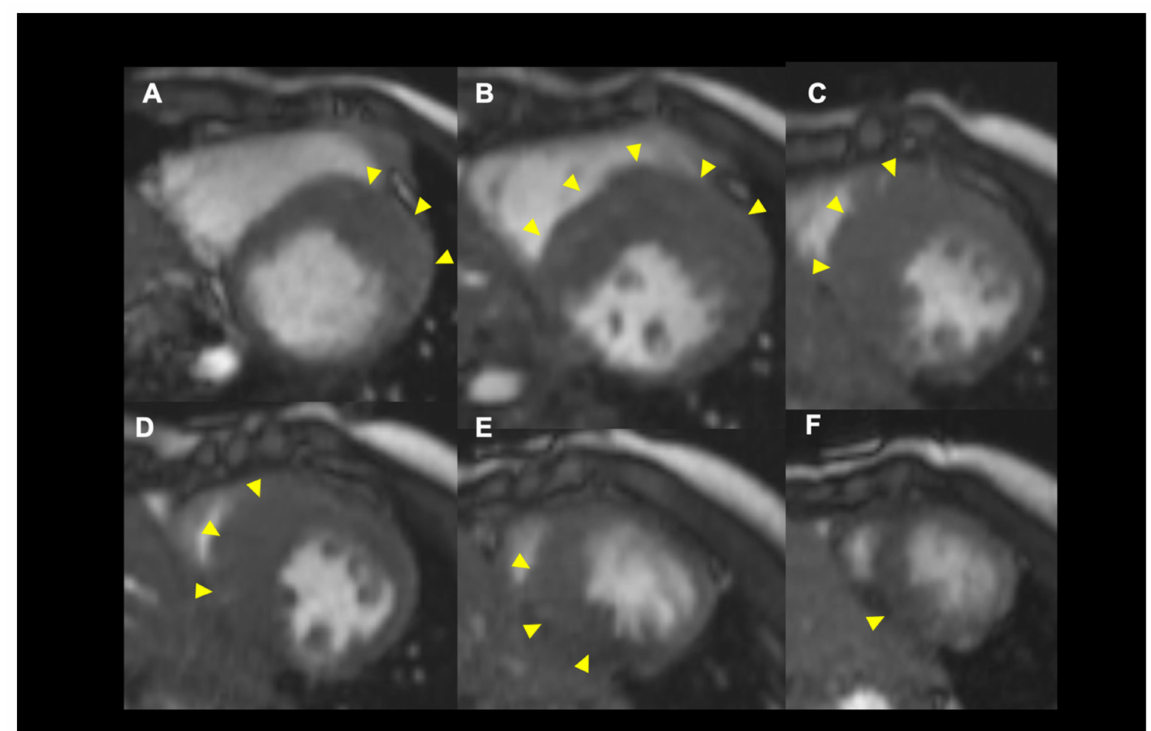
Figure 2. A representative case in which the hypertrophied region is changing along with the helical structure of myocardial fibers. The arrowheads indicate the location of hypertrophy. LV short axis views from the basal ( A ) to the apex ( F